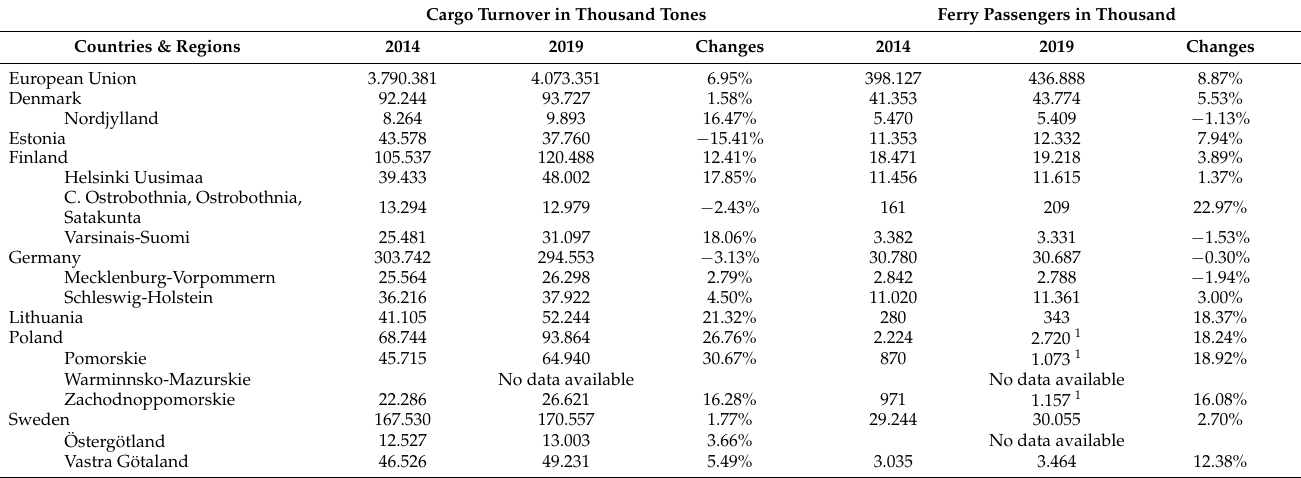
Table 3. Regional development on cargo and ferry for selected NUTS-2 regions and countries. Cargo Turnover in Thousand Tones Ferry Passengers in Thousand Countries &